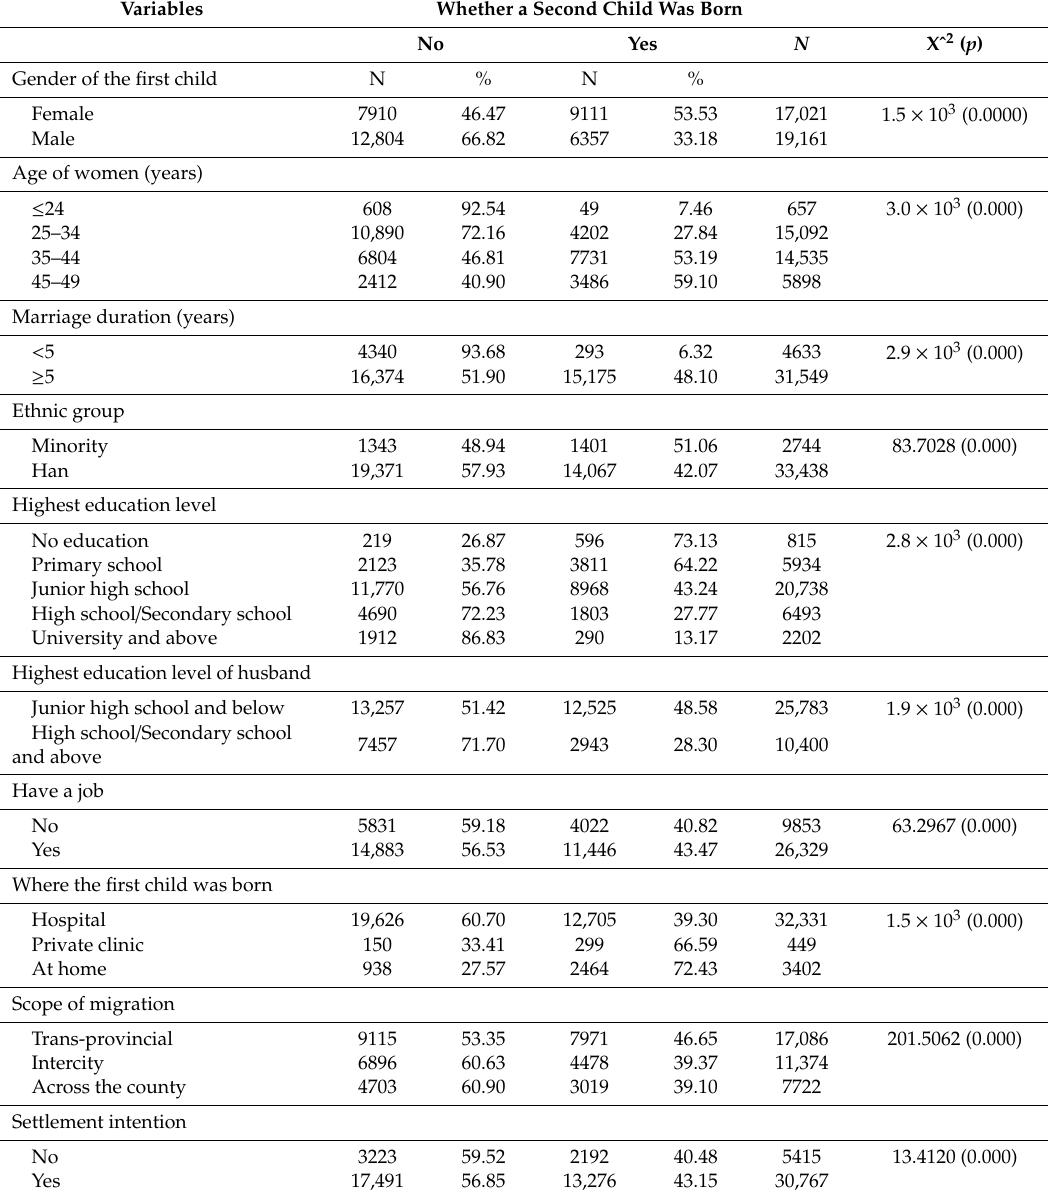
Table 2. Distribution of second-child fertility by sociodemographic variables ( N =